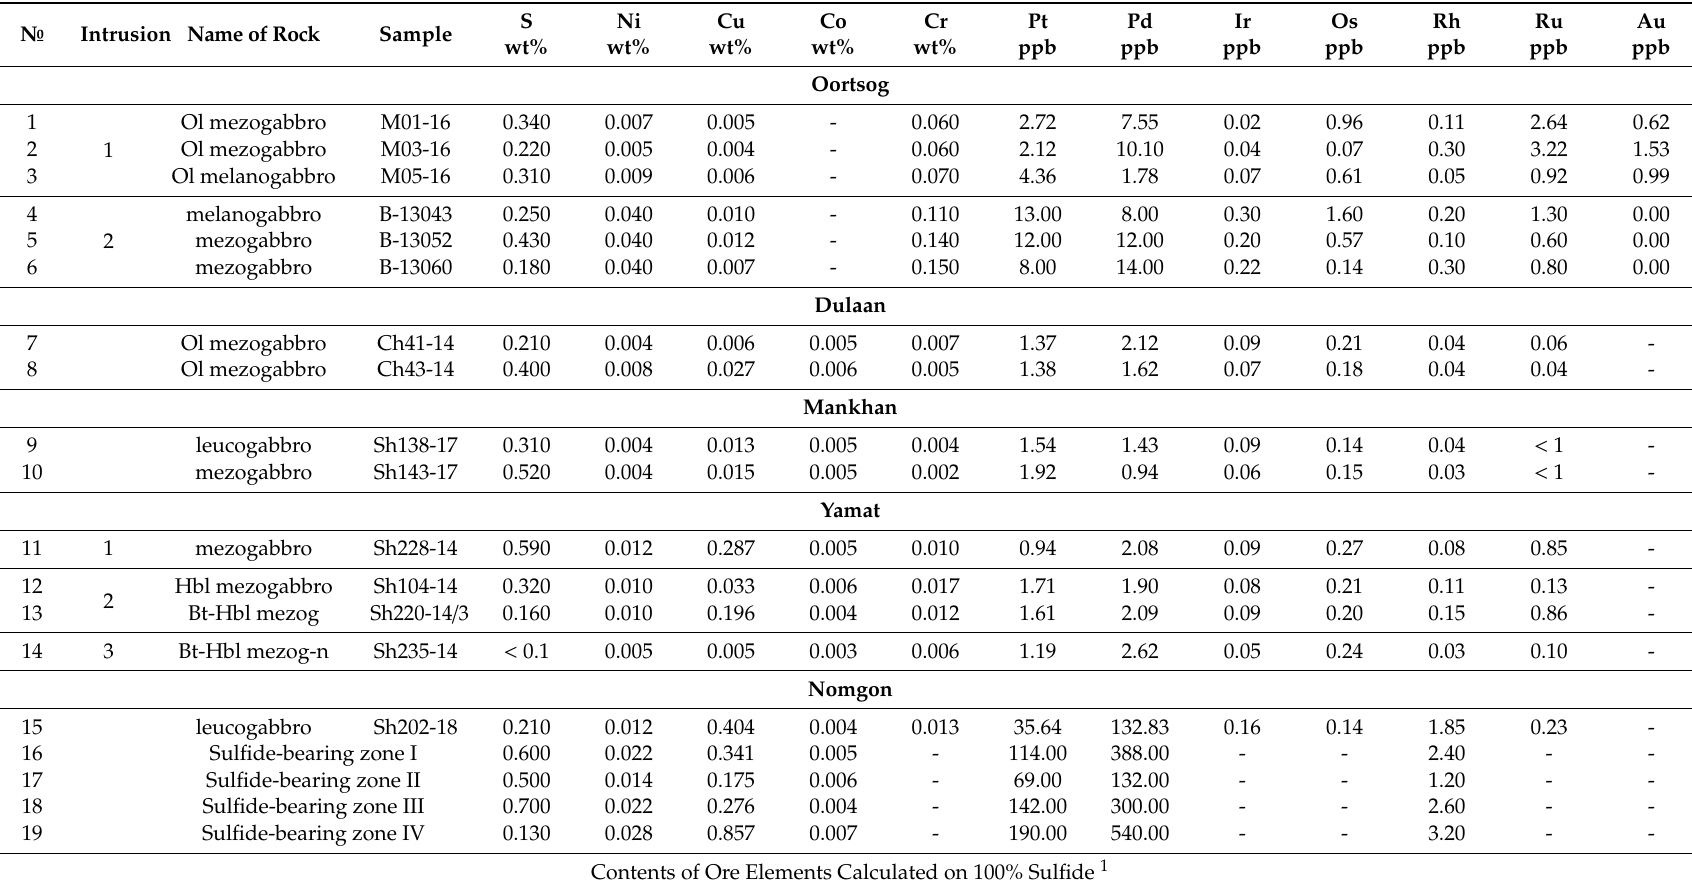
Table 4. Content of ore elements (wt%) and PGE (ppb) in mafic-ultramafic massifs of the Khangai